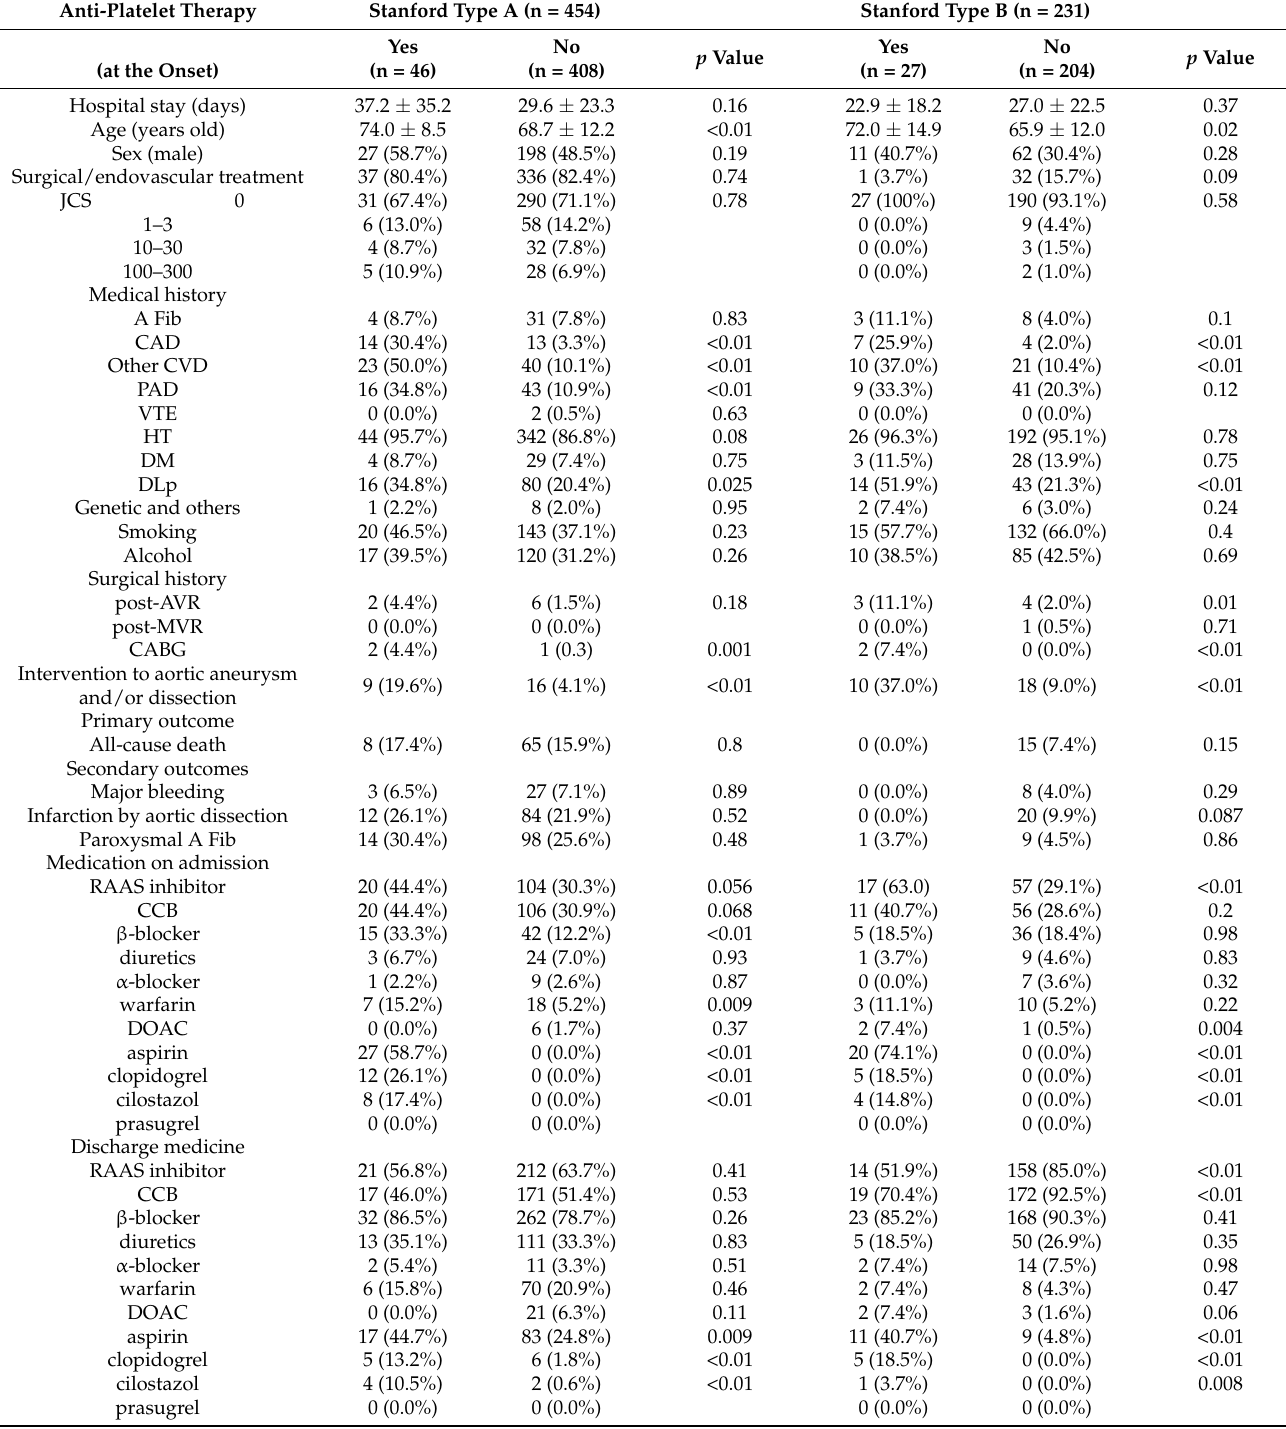
Table 3. Clinical characteristics of TRANSFERRED acute aortic dissection patients with and without anti-platelet